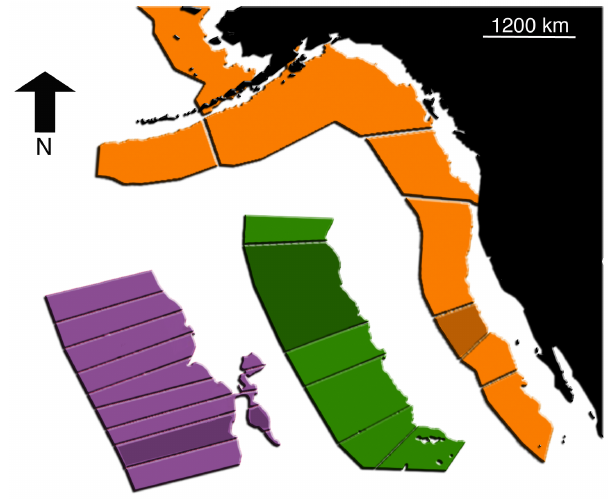
Figure 2. Map interface with delimited regions in the northeast Pacific. The interface allows users to identify location from which data were collected in the data entry process. Orange color represents regions, green sub regions and purple